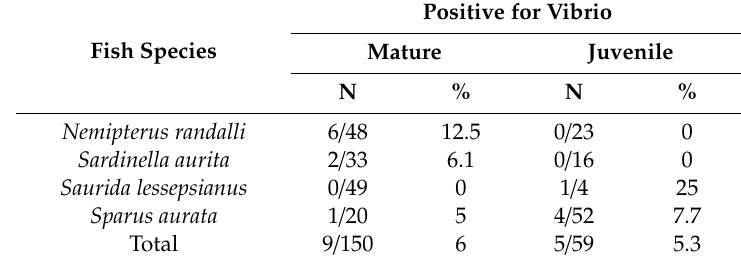
Table 4. Relative distribution and percentage of Vibrio in juvenile and adult wild and cultured fish.